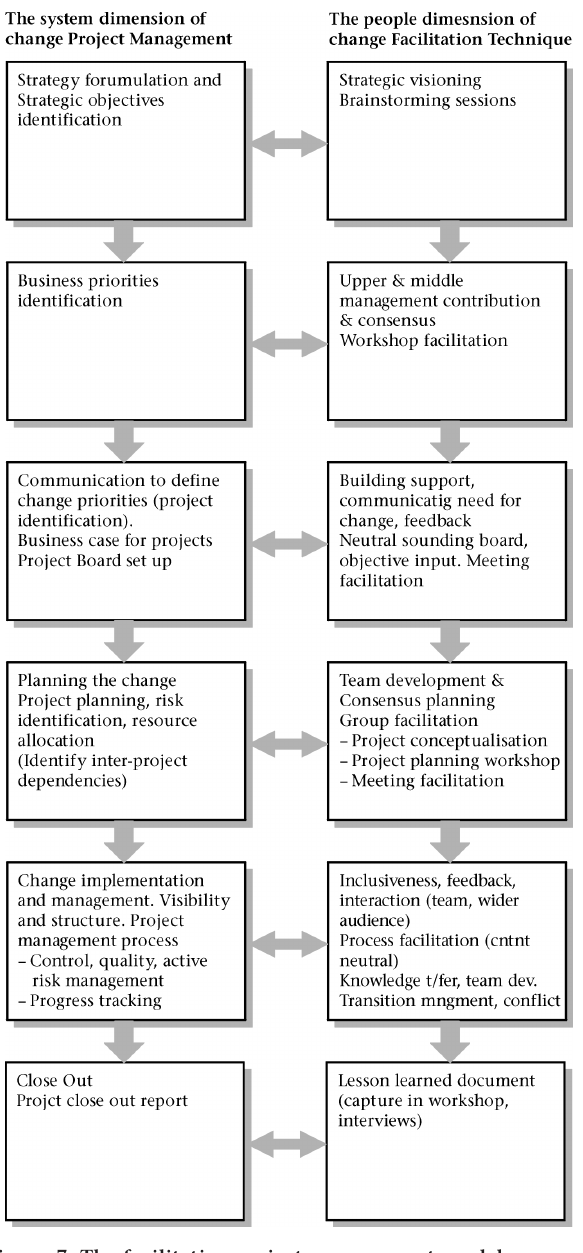
Figure 7: The facilitative project management model for integrated change implementation version 2